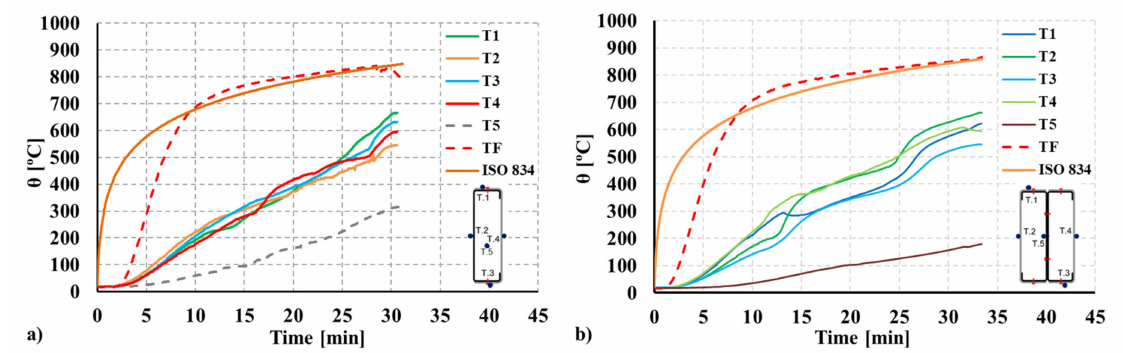
Figure 7. Temperature evolution monitored during the tests for the T.S.3 section. ( a ) R composite section. ( b ) 2R composite section.